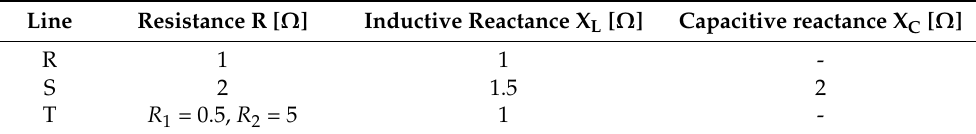
Table 1. List of phase impedances with division of resistance, inductive, and capacitive reactance values. Line Resistance R [ Ω ] Inductive Reactance X L [ Ω ]